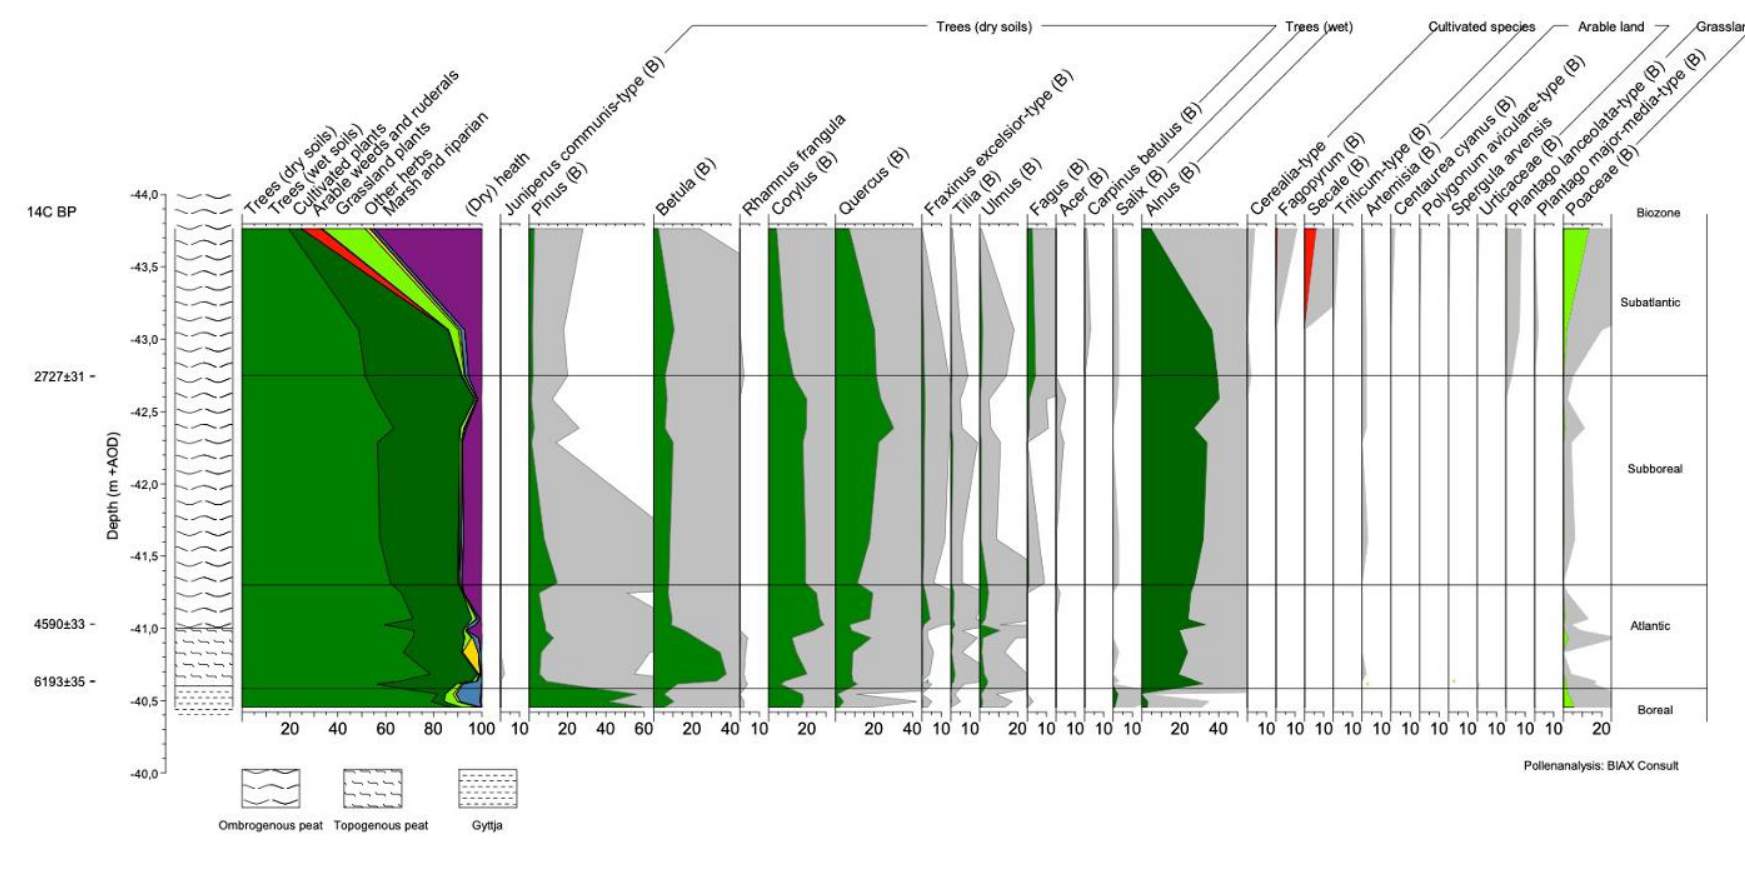
Figure 6. Simplified pollen diagram for Core